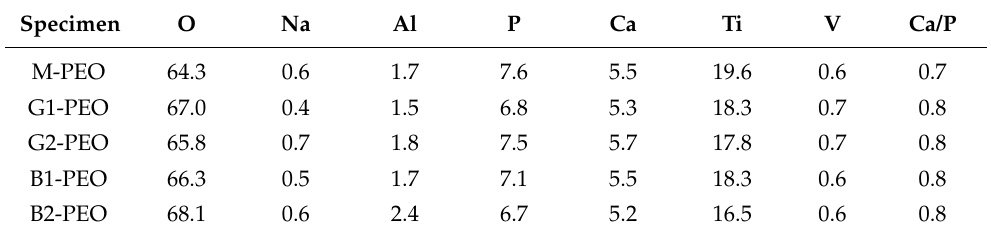
Table 4. Energy dispersive X-ray spectroscopy (EDS) of PEO-treated specimens. Values given in at.%.